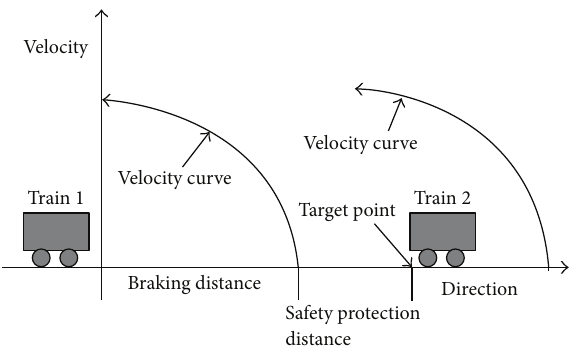
Figure 1: Schematic of moving block